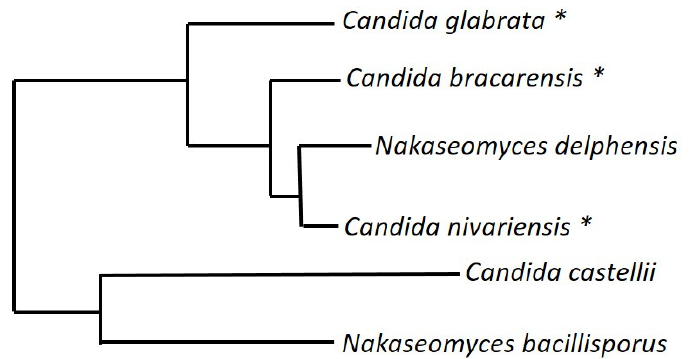
Figure 6. The Nakaseomyces genus. The six species that comprise the Nakaseomyces genus, three of which marked with * are pathogenic. This clade is separate from the CTG-clade compromising of the other Candida species.